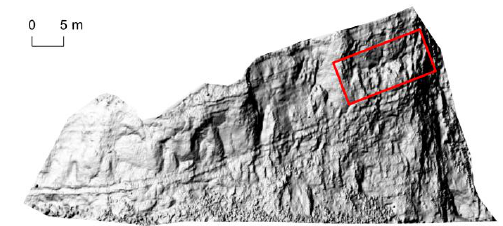
Figure 7. Geomorphic features extracted using the threshold of 2  of C min ( C min  - 2  ) and a moving window of 7x7